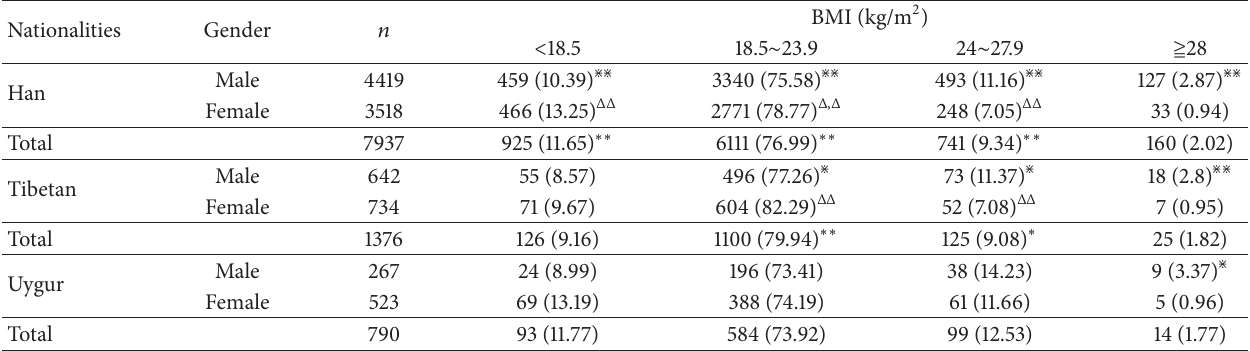
Table 2: BMI distributions of Han, Tibetan, and Uygur university students.